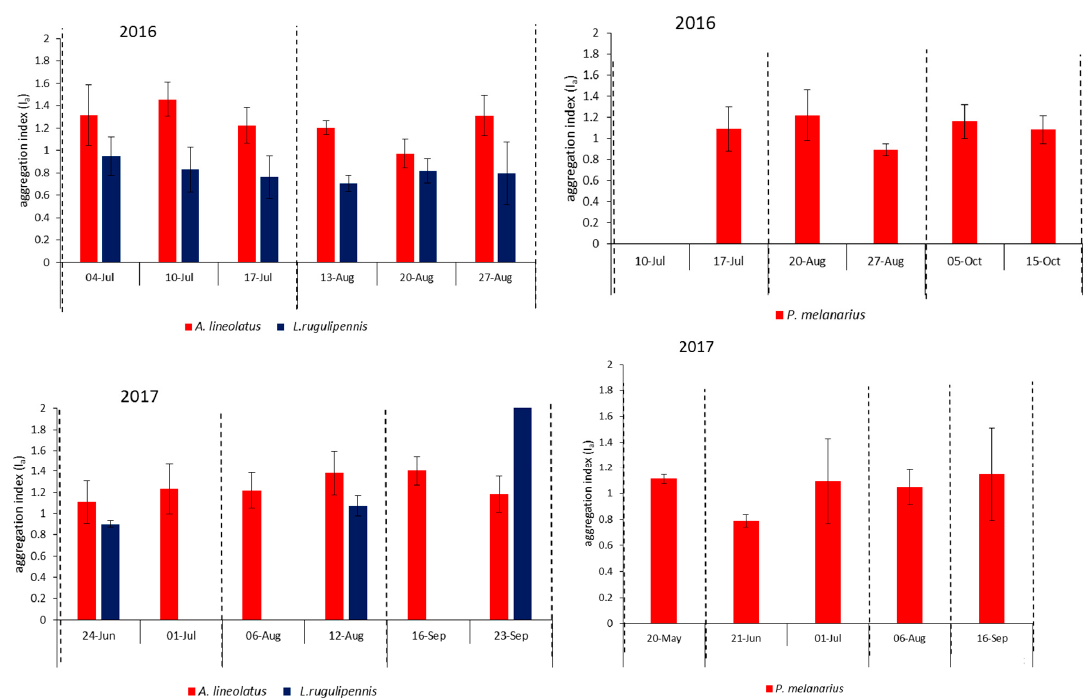
Figure 4. The average of the aggregation ( Ia ) index of plant bugs (left) and Pterostichus melanarius (right) in 2016 and 2017 (dashed lines indicate alfalfa harvest times). Bars indicate standard errors .